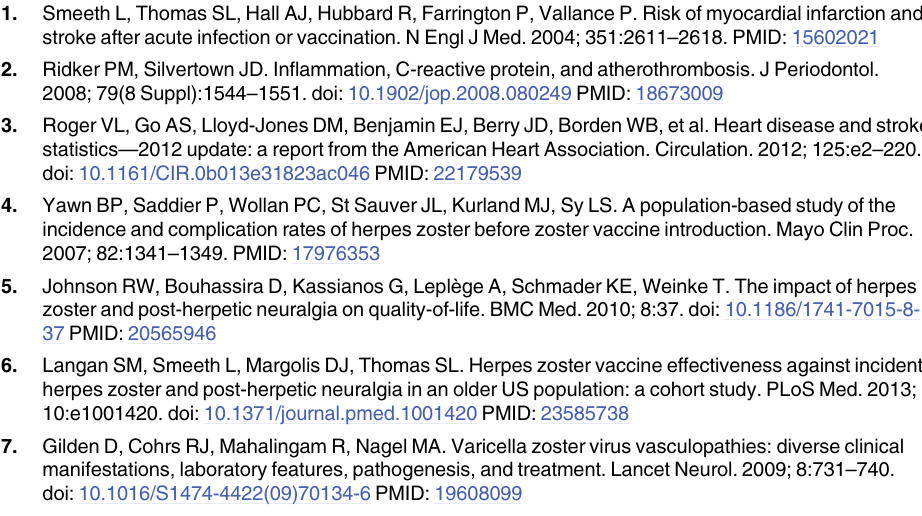
S1 Table. Participant characteristics stratified by vaccination status. S2 Table. Allowing for nonrandom censoring of